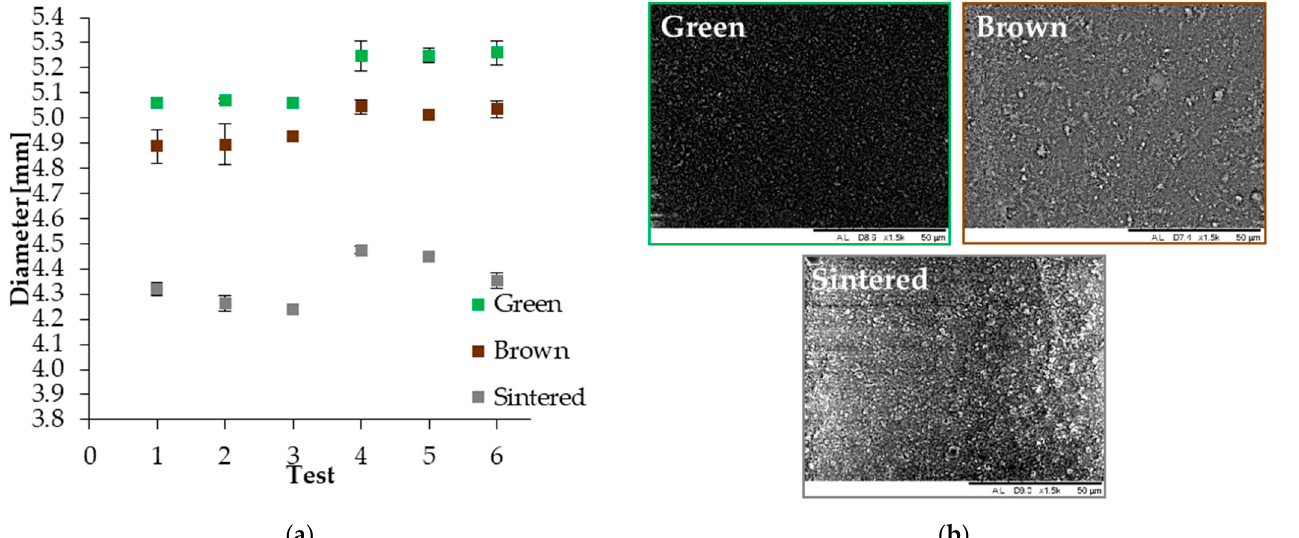
Figure 7. ( a ) Diameter dimension evolution. ( b ) SEM images of green, brown, and sintered T1 samples, respectively.